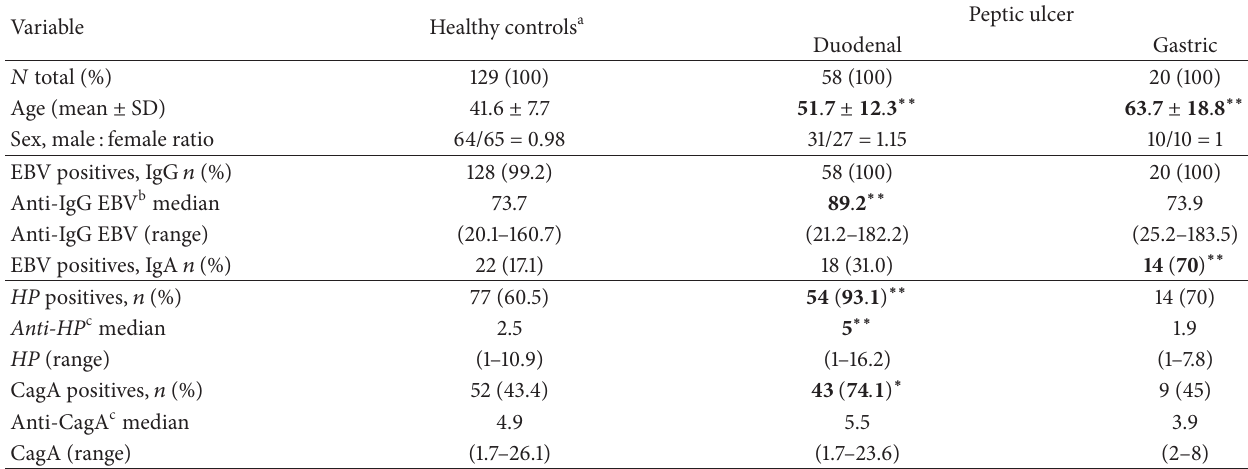
Table 1: General description of the study